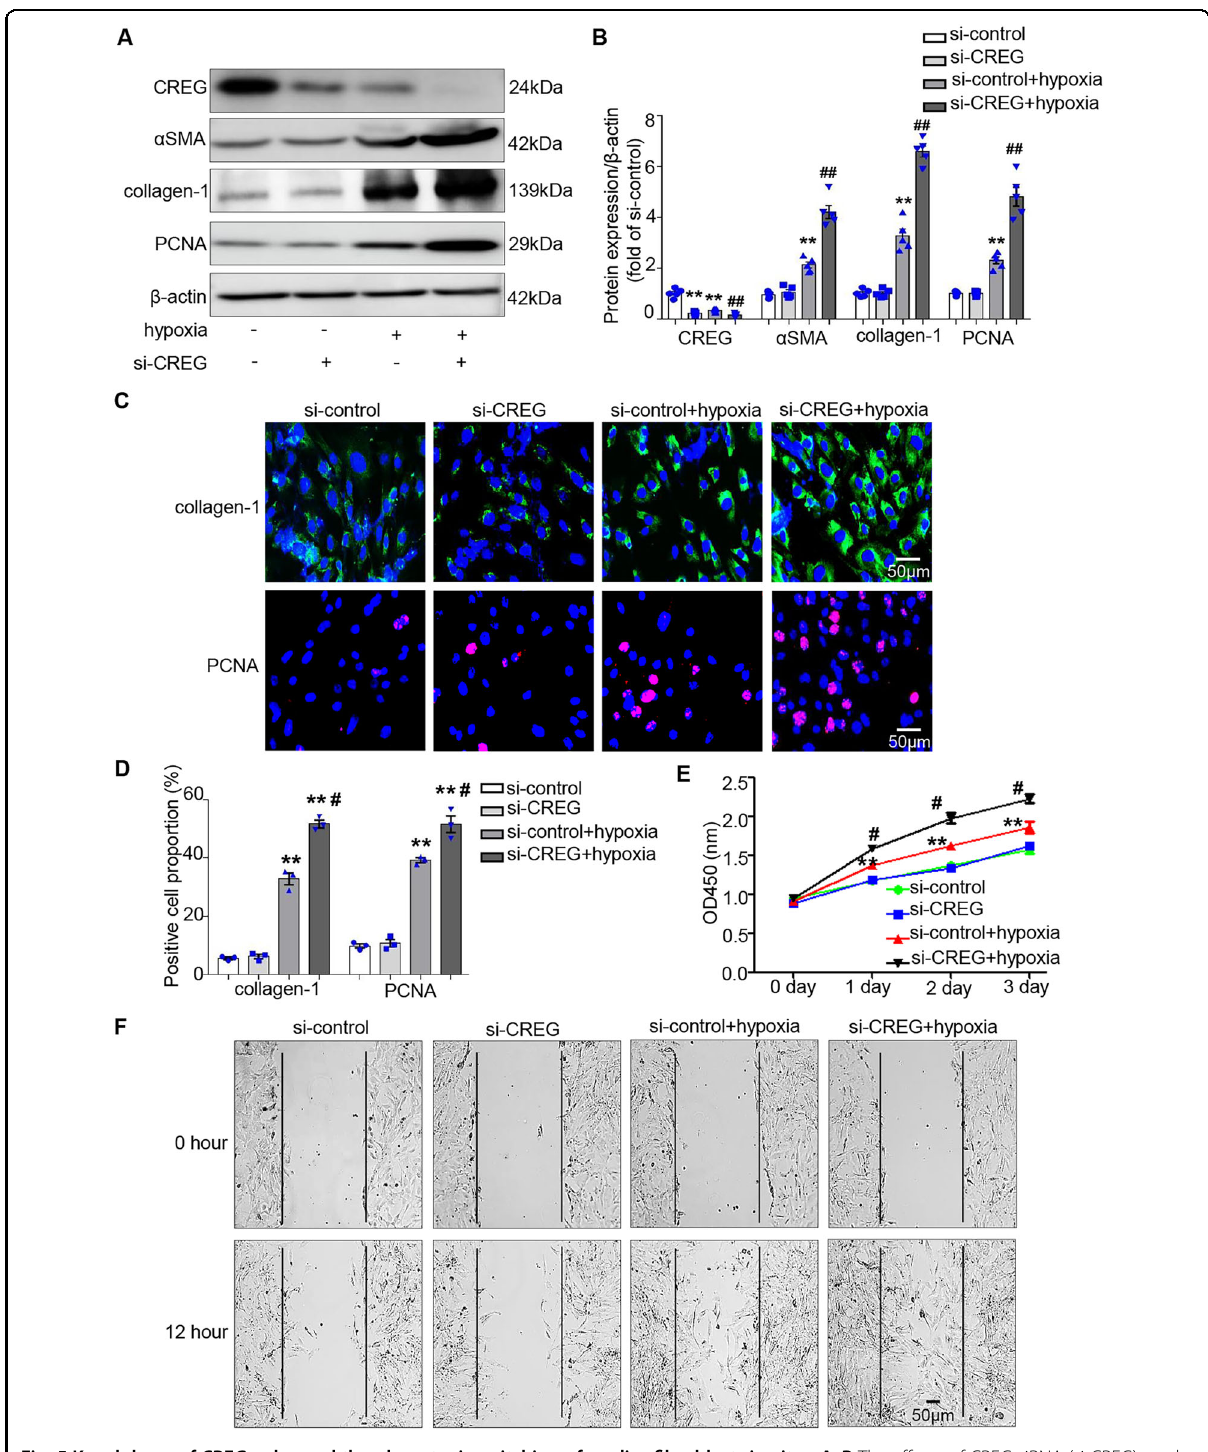
Fig. 5 Knockdown of CREG enhanced the phenotypic switching of cardiac fi broblasts in vitro. A , B The effects of CREG siRNA (si-CREG) on the expression of α SMA and collagen-1 induced by hypoxia as determined by western blotting ( N = 5 per group). C , D The effects of si-CREG on the expression of collagen-1 and PCNA induced by hypoxia as determined by immuno fl uorescence staining ( N = 3 per group). Green indicated collagen- 1 expression, red indicated PCNA expression, and blue indicated nuclei. E The effects of si-CREG on cell proliferation were determined by CCK8 assays ( N = 5 per group). F The effects of si-CREG on cell migration were determined by wound healing assays ( N = 3 per group). ** P < 0.01 vs. si-control group; ## P < 0.01, # P < 0.05 vs. si-control + hypoxia